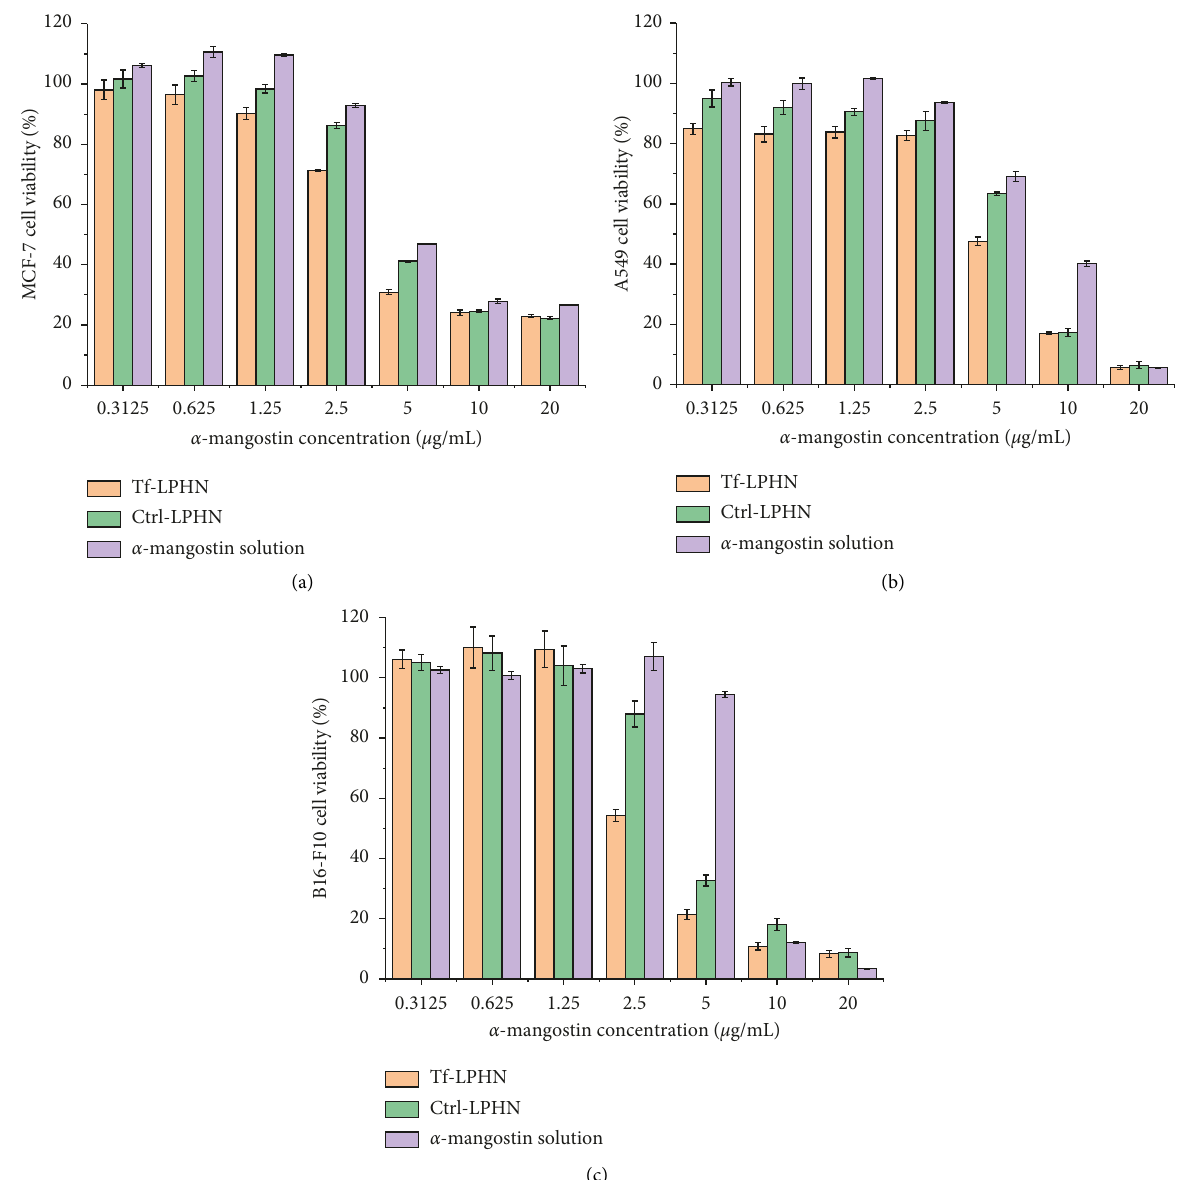
Figure 5: Percentage cell viability after being treated with α -mangostin either entrapped in Tf-LPHN (orange), Ctrl-LPHN (green), or as a drug solution (purple) on MCF-7 (a), A549 (b), and B16–F10 (c) cell lines, for 48 h ( n �